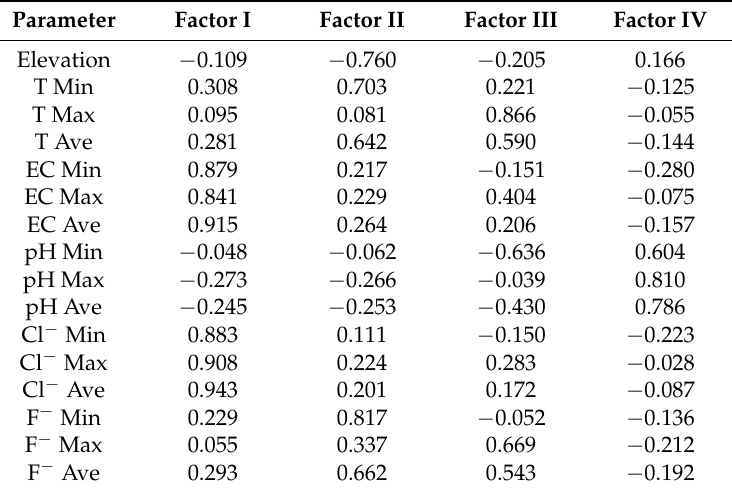
Table 2. Factor score for the applied factor analysis